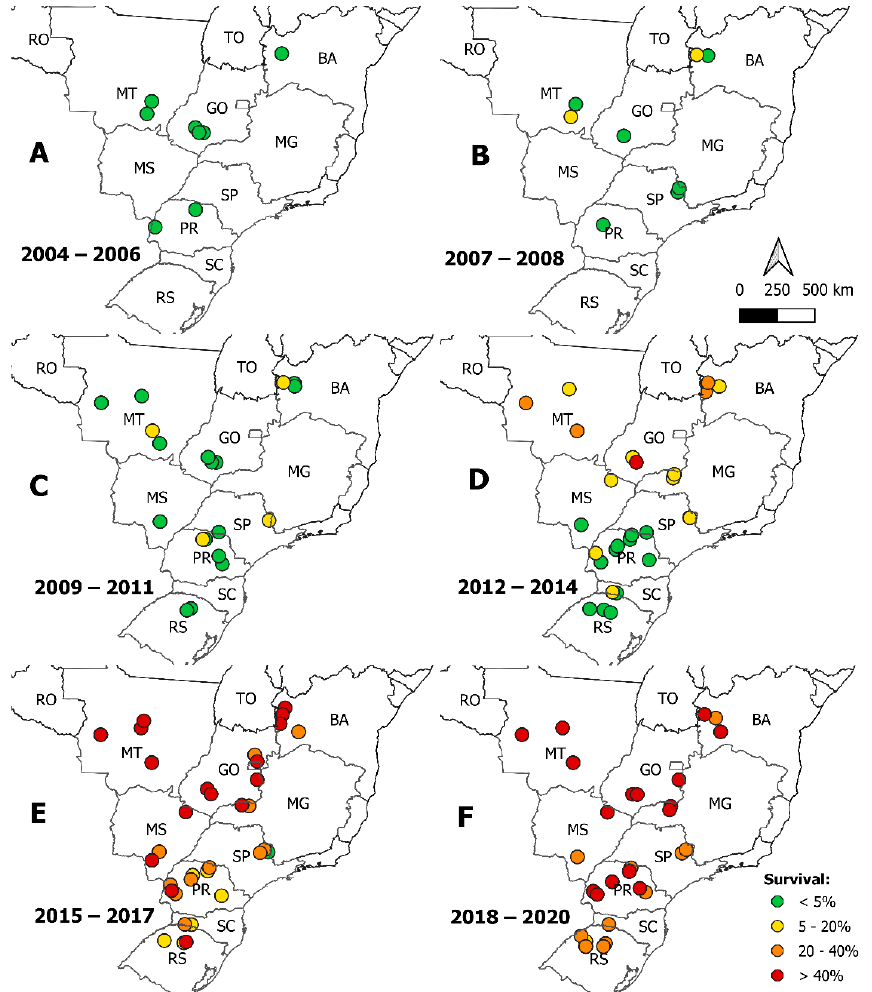
Figure 3. Spatial distribution of Spodoptera frugiperda survival to teflubenzuron at diagnostic concentrations. Each colored dot is a different tested population. ( A ) shows safe survival levels (less than 5%) in all evaluated locations; ( B ) shows an increase in survival to a warning level (5 to 20% survival) in northeast and northwest areas; ( C ) shows the warning spreading to other areas; ( D ) warning level spread to other locations (20 to 40%), and the critical level (> 40%) is shown; ( E ) shows the spread of the critical level all over the country; ( F ) shows how critical survival rates are maintained over the years.